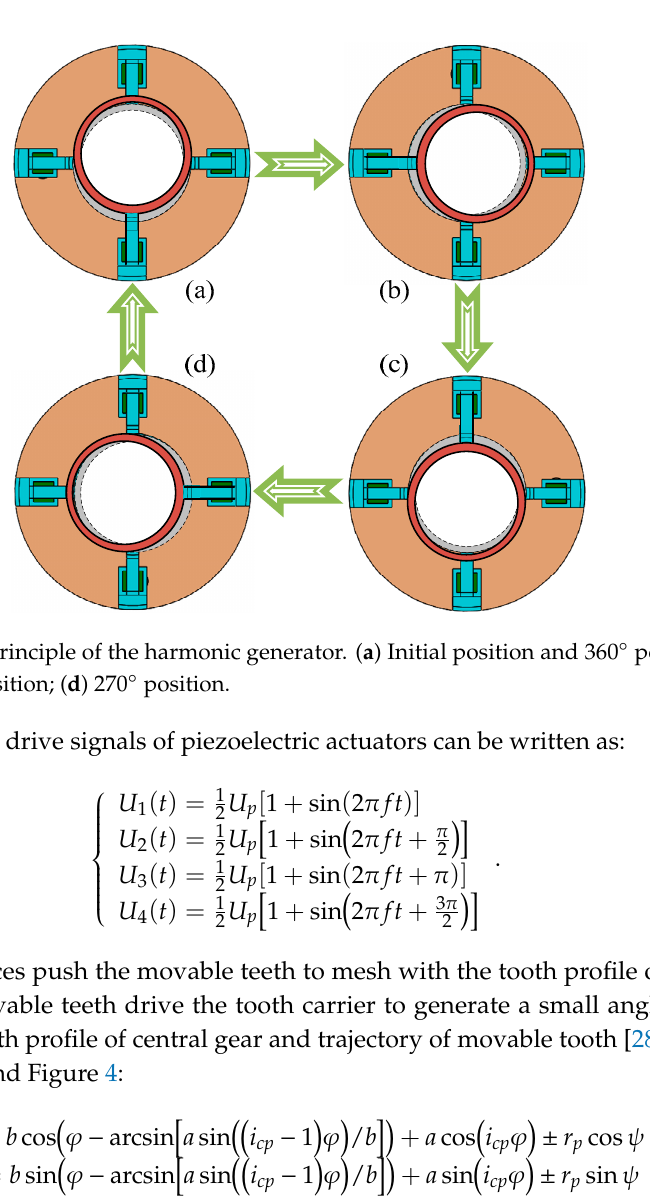
Figure 2. Driving signals of piezoelectric actuators.